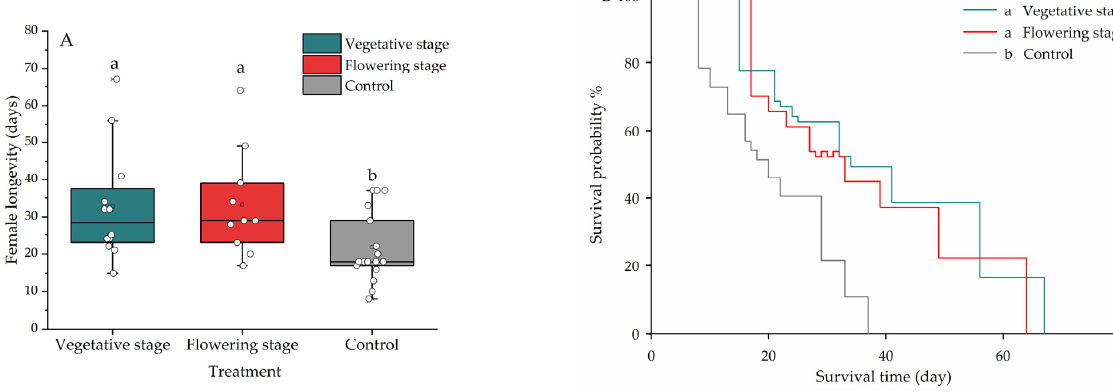
Figure 4. Effect of Ocimum basilicum phenological stage on the ( A ) longevity and ( B ) survival of female Chrysopa pallens adults. The results are shown for vegetative and flowering O. basilicum , as compared to the control treatment. Kaplan–Meier curves are drawn to depict the C. pallens survival dynamics under different treatments. Different letters indicate statistically significant differences among treatments (ANOVA, Fisher’s LSD test for mean separation, p <